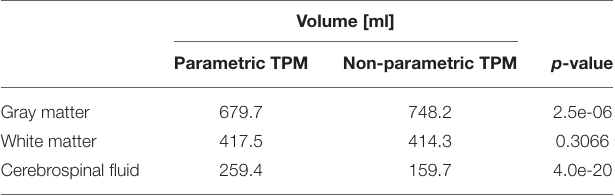
TABLE 3 | The results of the Wilcoxon signed-rank test p-values (p*) of the parametric and non-parametric TPMs comparison.